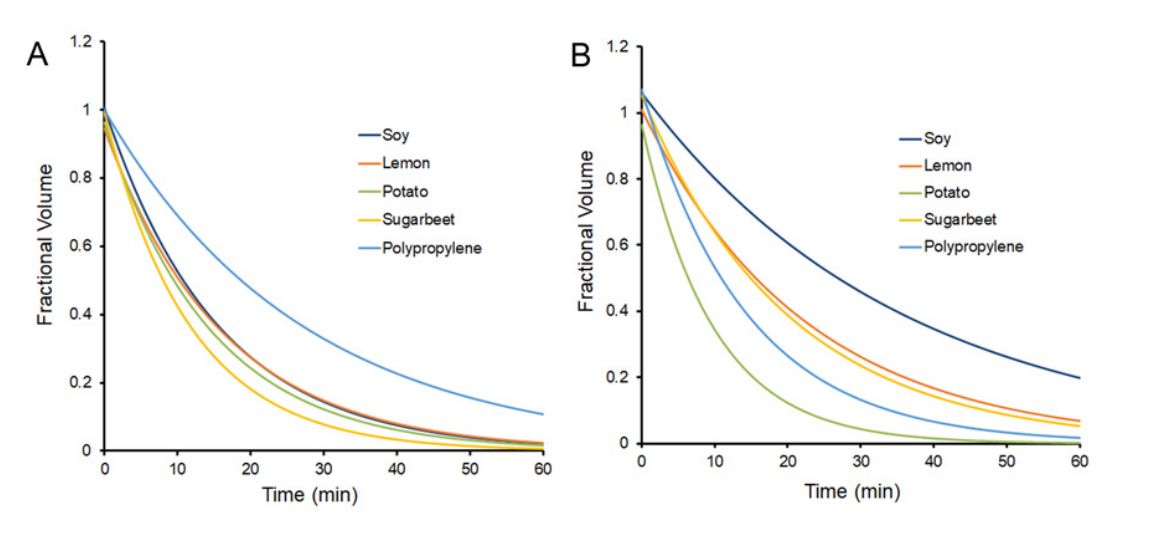
Figure 4. The kinetics of the passive absorption and evaporation of the water ( A ) and pleural fluid ( B ) droplets was assessed by timelapse video and planar morphometry (MetaMorph, Molecular Devices). The fractional residual volume was studied in all 4 plant sources as well as a polypropylene evaporative control. The median curve of 5 replicate samples is shown.